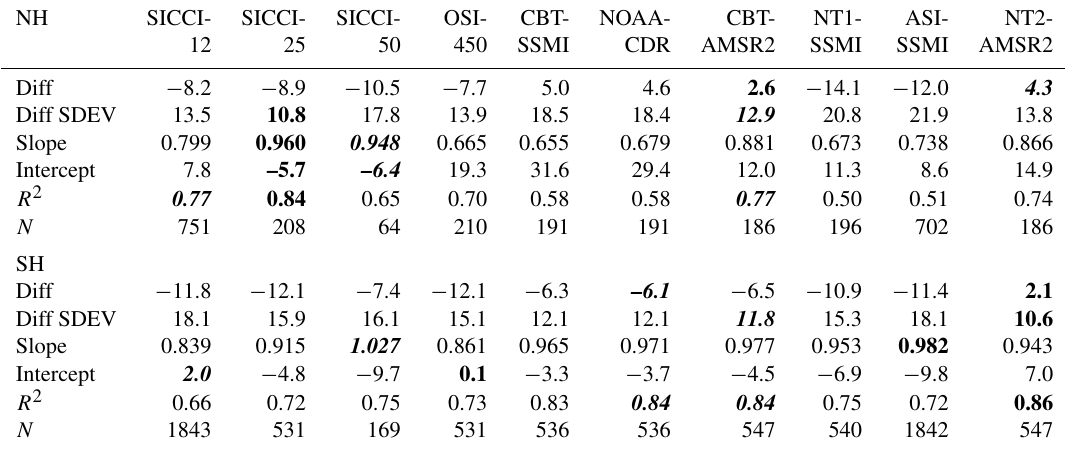
Table 9. Summary of statistical results obtained for three freeze-up cases in the Northern Hemisphere (NH) and for 11 freeze-up cases in the Southern Hemisphere (SH) using Landsat 8 data. See Table 5 for an explanation of the parameters given.